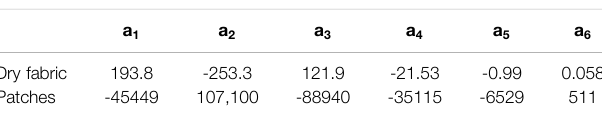
TABLE 1 | Polynomial coef fi cients for dry and patched fabric as used in